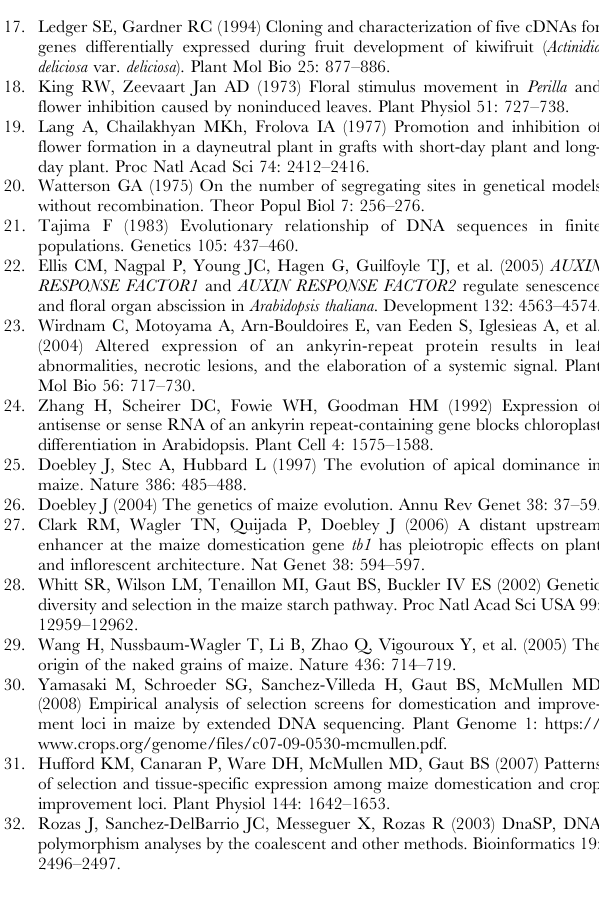
Table S3 A summary of the marker-trait associations.